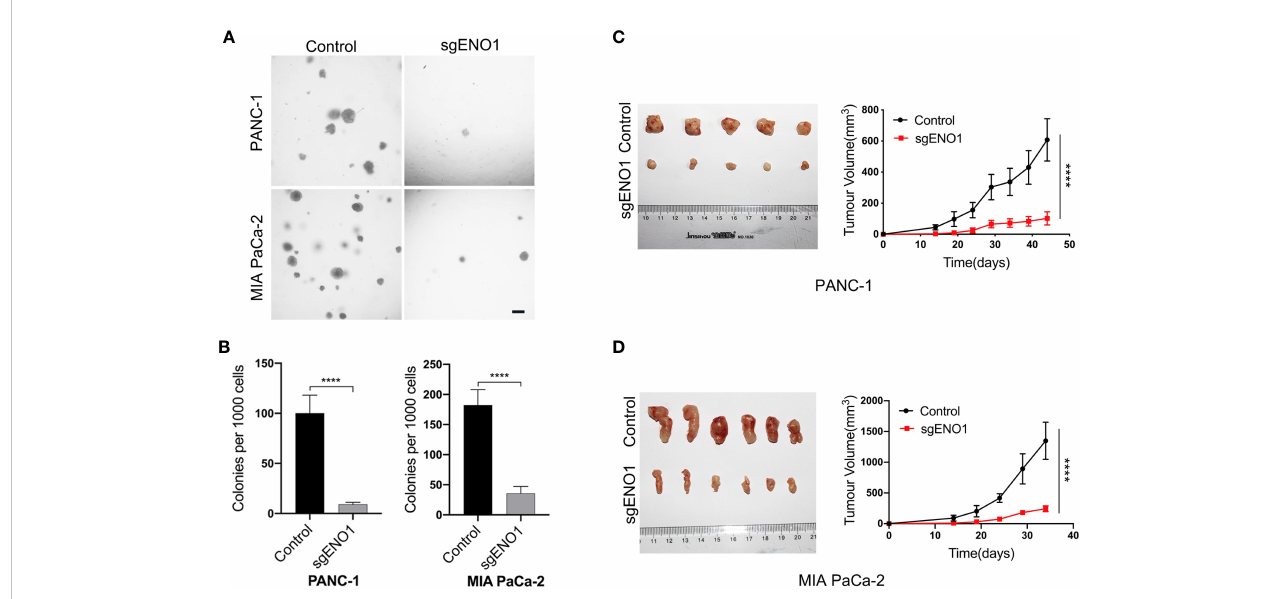
FIGURE 5 ENO1 knockout reduced tumorigenicity of PDAC cells. (A, B) The colony formation ability of PANC-1 and MIA PaCa-2 cells reduced after ENO1 knockout; scale bars, 100 m m. (C, D) The mice tumor growth curves originated from subcutaneous injection of ENO1 knockout and control cells are shown. (each group had 6 mice, one mouse died in the PANC-1 cell group);